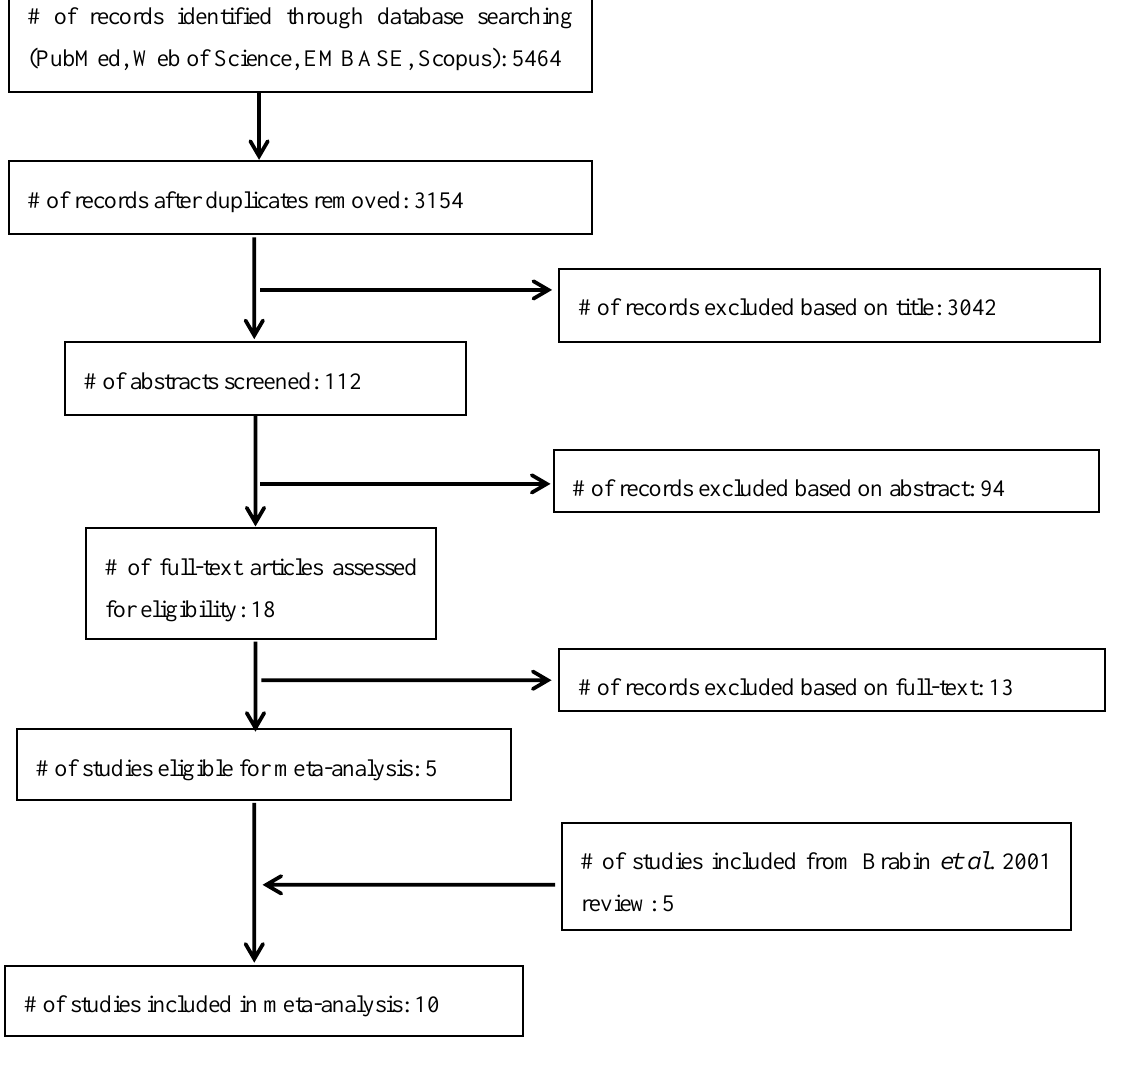
Figure 1. Article search and selection